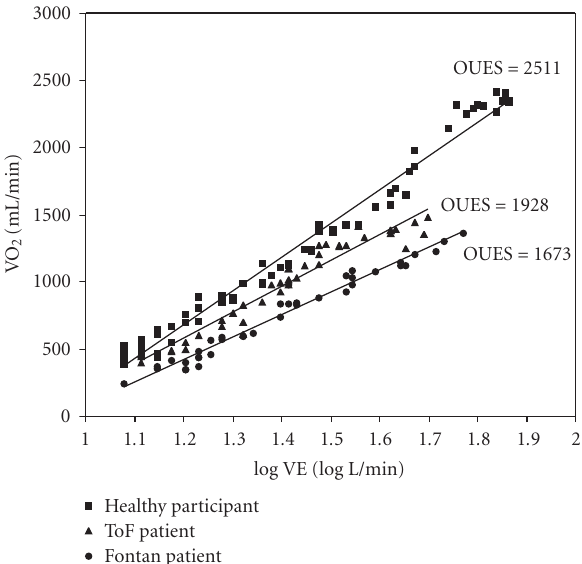
Figure 2: The OUES during an exercise test in a healthy 13-year-old boy, in a sex- and age-matched patient with tetralogy of Fallot, and in a sex- and age-matched Fontan